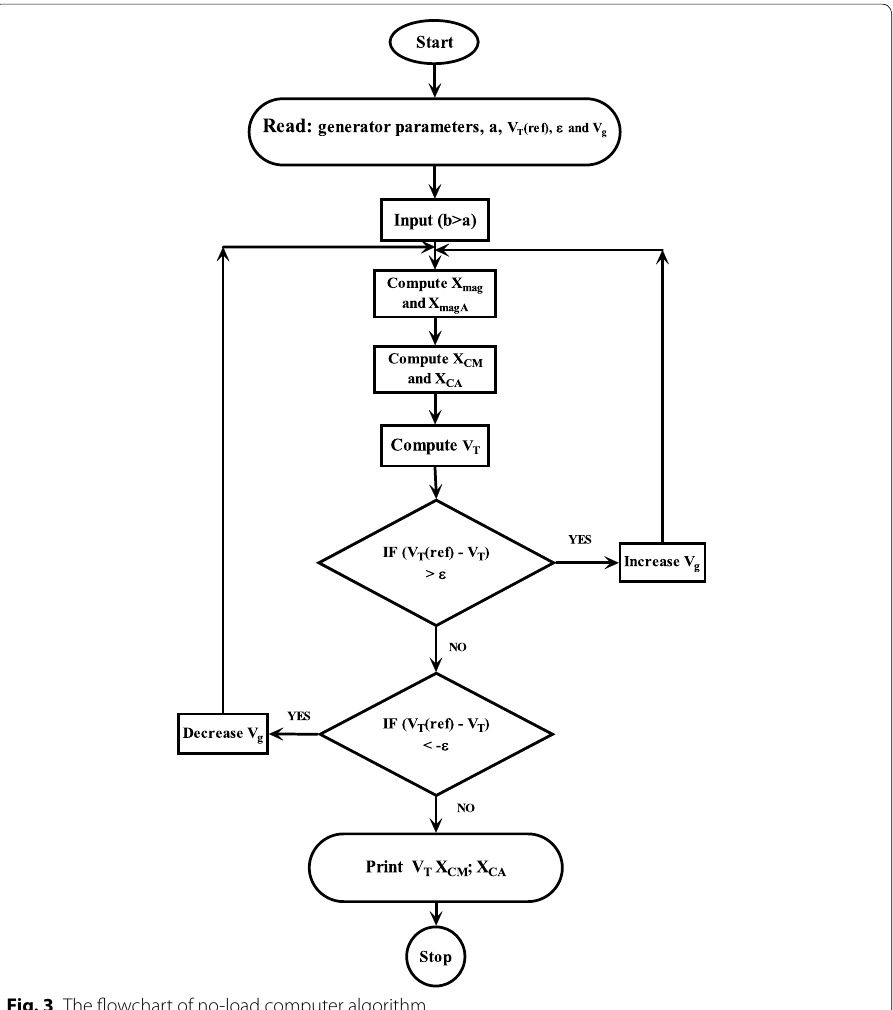
Fig. 3 The flowchart of no-load computer